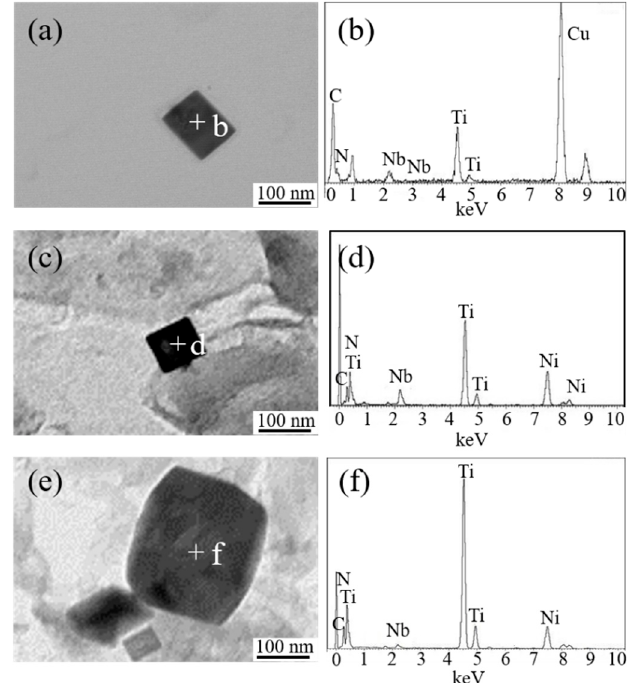
Figure 7. TEM image and corresponding energy dispersive spectrometer (EDS) analysis of the nanoscale particles in simulated HAZs. ( a , b ) A, ( c , d ) LM, and ( e , f ) HM.